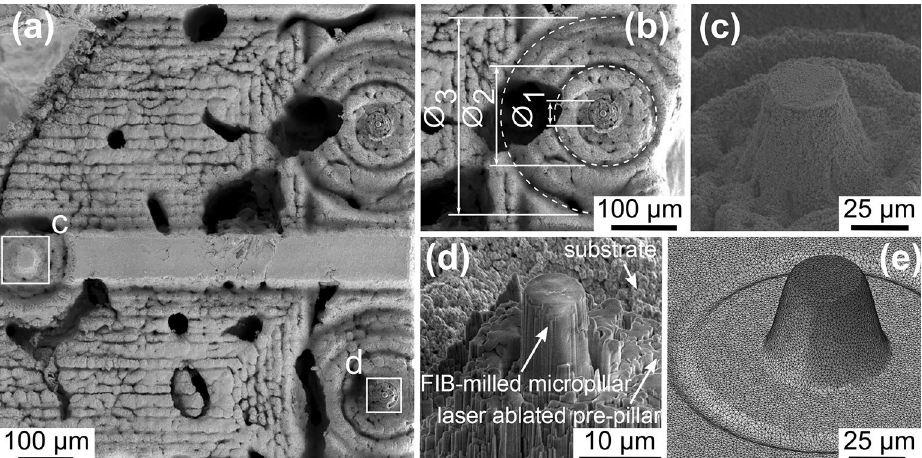
Figure 1. Micropillar extraction overview. ( a ) SEM image of a the final processed MTLT sample, with two micropillars present 41 . ( b ) area ablated by spiral inbound anticlockwise hatch patterns, where ∅ 1 = 32.85 ± 0.91 µ m , ∅ 2 = 150 µ m , ∅ 3 = 300 µ m 41 ( c ) SEM image of a pre-pillar 41 . ( d ) SEM image of a FIB milled micropillar 33 . ( e ) finite element mesh of the pre-pillar. The circular groove here corresponds to ∅ 2 in ( b ); where the scanning patterns of the outer and inner spiral hatch patterns